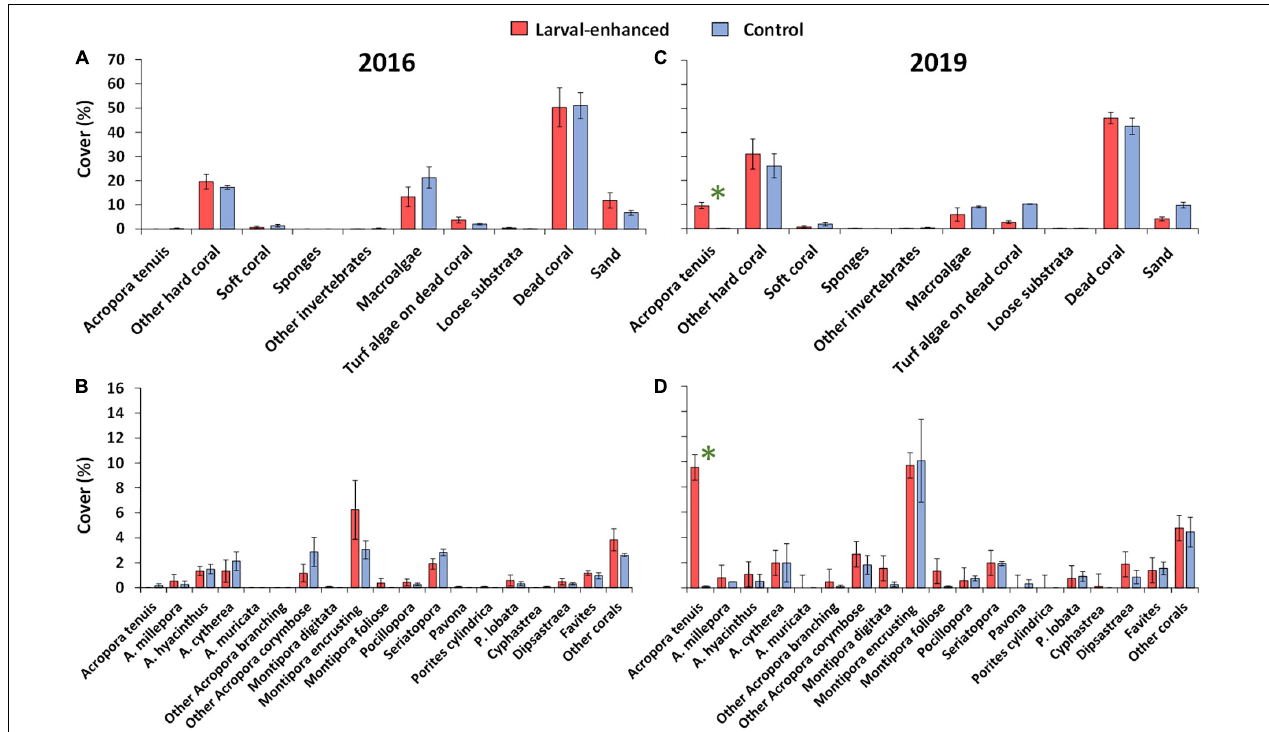
FIGURE 9 | Mean percentage cover of major benthic categories prior to larval enhancement in 2016 (A) and 35 months after larval enhancement in 2019 (B) , also mean percentage cover of coral categories prior to larval enhancement in 2016 (C) and 35 months after larval enhancement in 2019 (D) . Error bars are ± SE. N = 3 for both larval enhanced and control plots. Asterisk denotes significant difference in mean cover of A. tenuis between larval-enhanced and control plots.